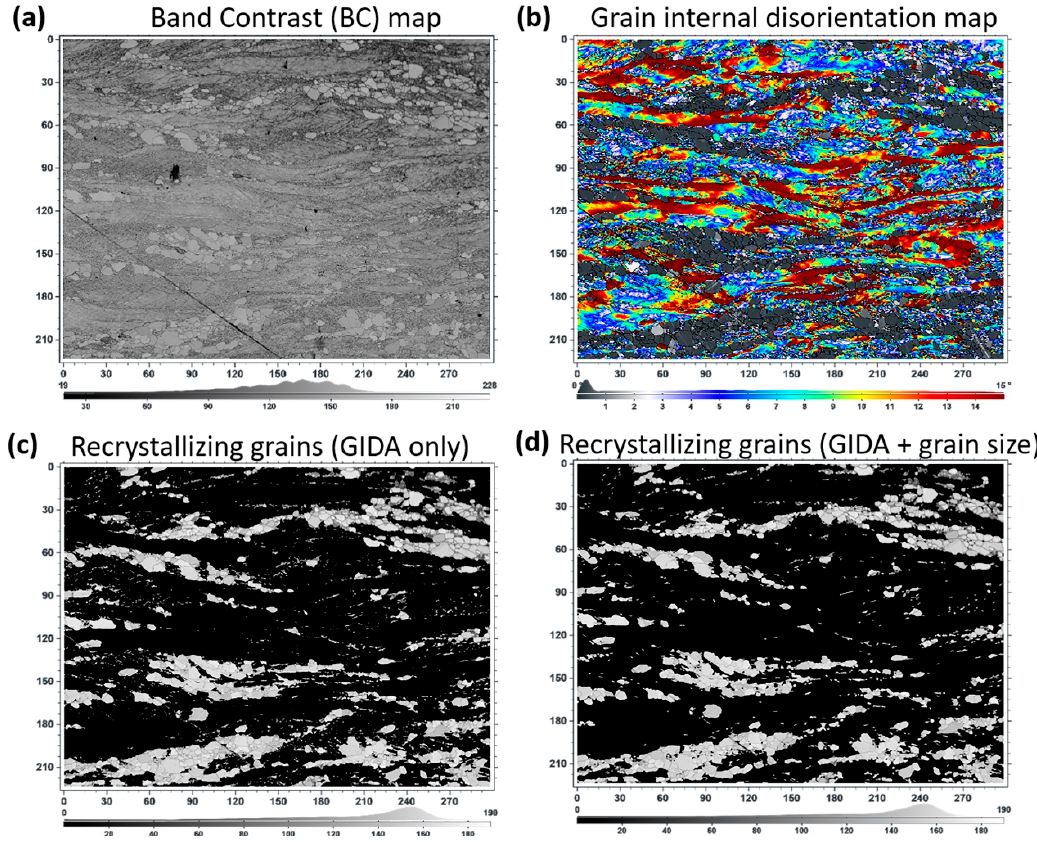
Figure 16. Band contrast map ( a ) and Grain internal disorientation average map ( b ); Partitioning of partially recrystallized microstructure based on the value of the grain internal disorientation average (GIDA) alone, ( c ) as well as with the addition of grain size filter ( d ).